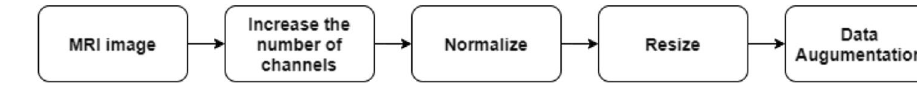
Fig. 6 Data pre-processing steps